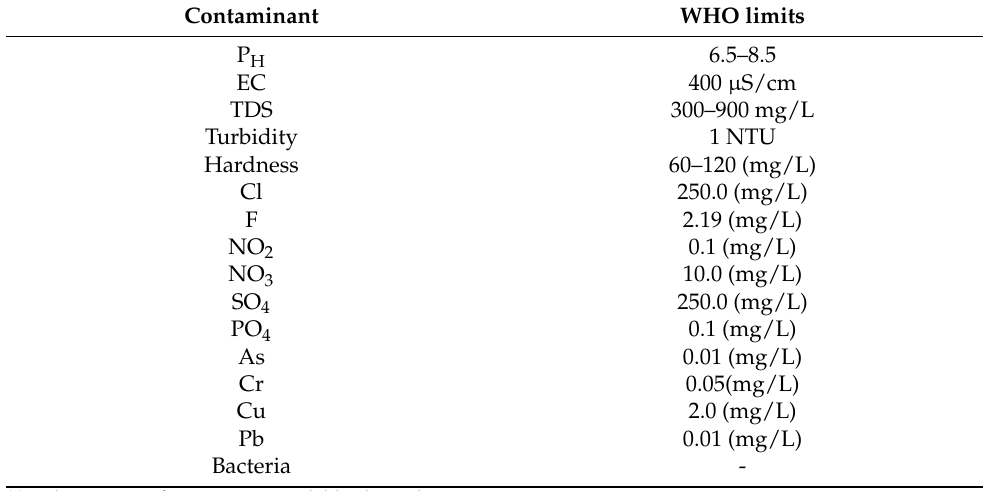
Table 2. Drinking water quality guidelines given by the World Health Organization